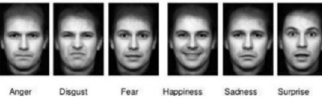
Fig. 2. Classification of facial